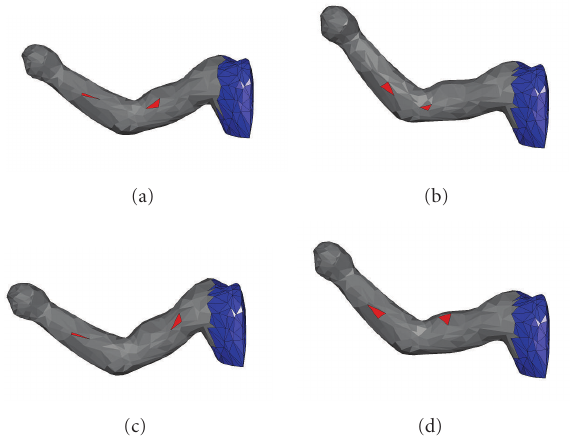
Figure 11: Locations of triangles. Our method works even when the handle triangle is placed distally (b), proximally (c), or on the region where a muscle bulges (d).